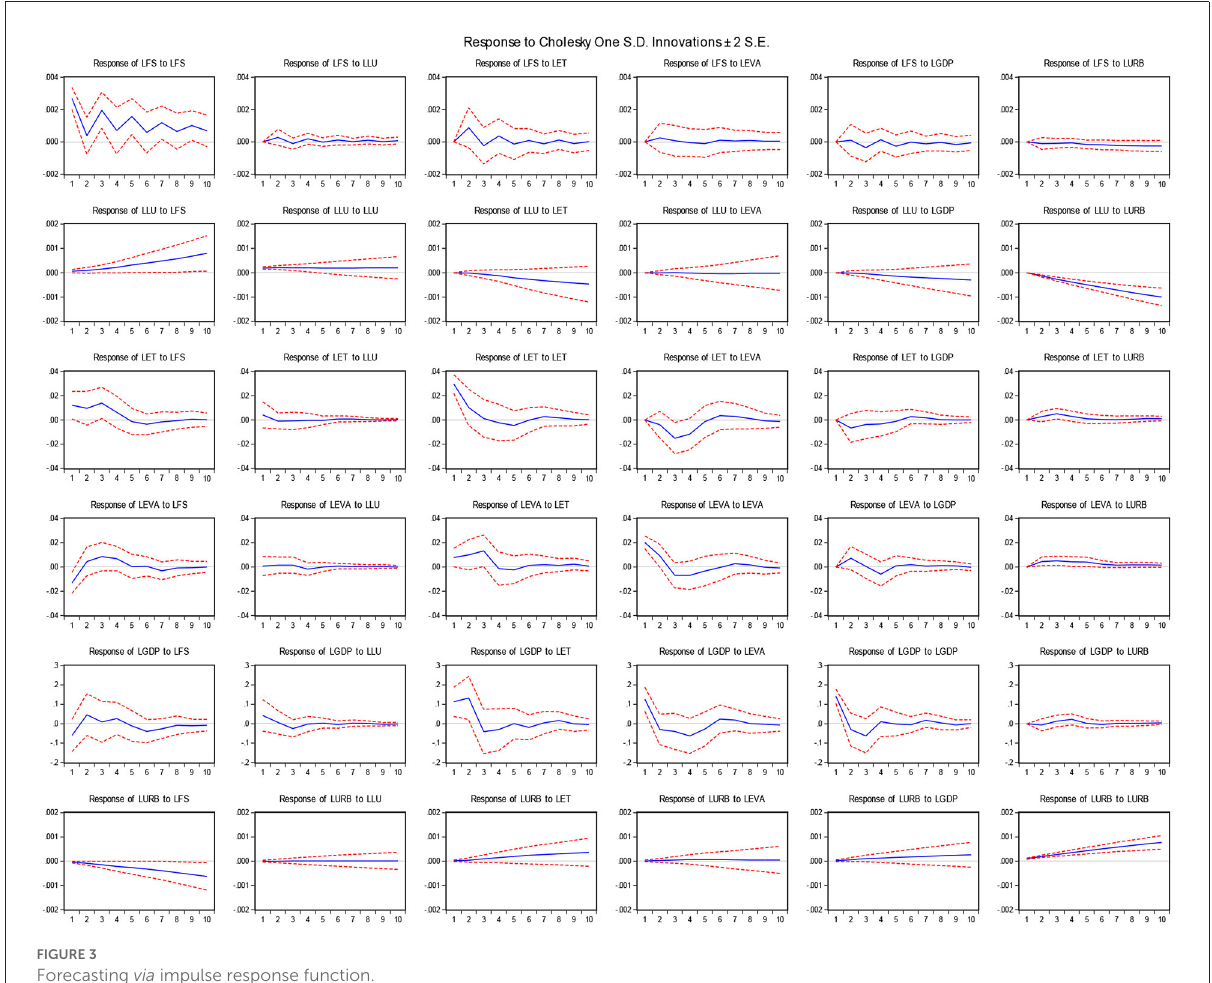
FIGURE3 Forecasting via impulse response function.